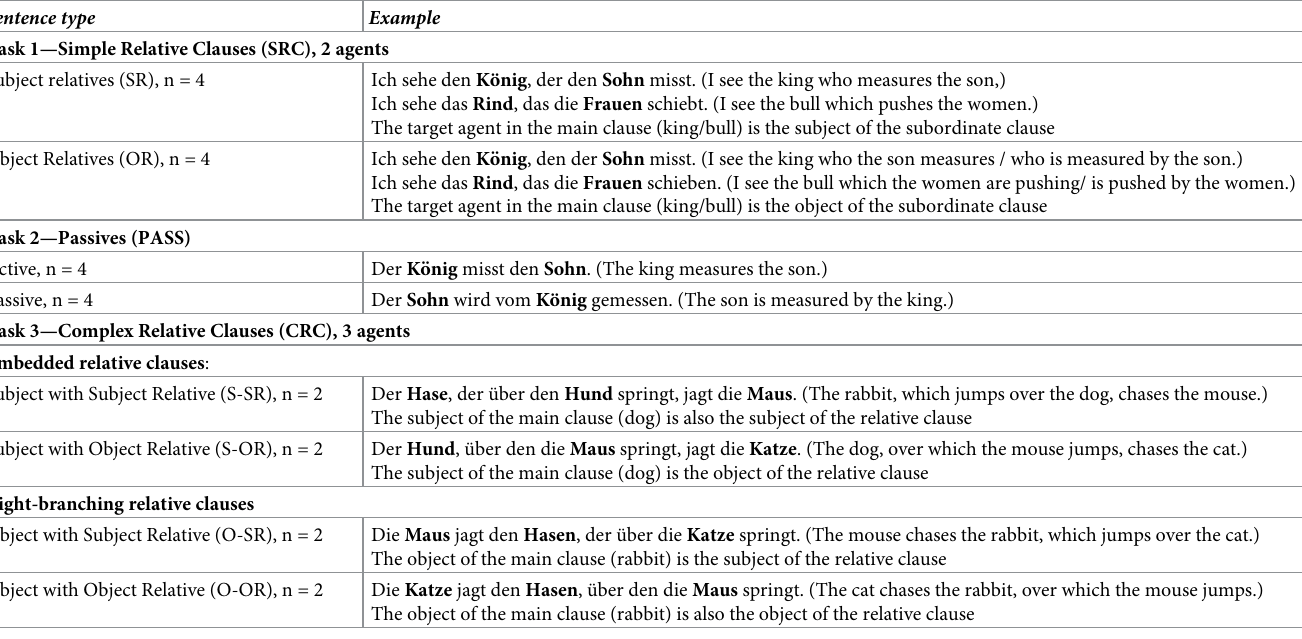
Table 2. Example structures for grammar tasks 1–3. Sentence